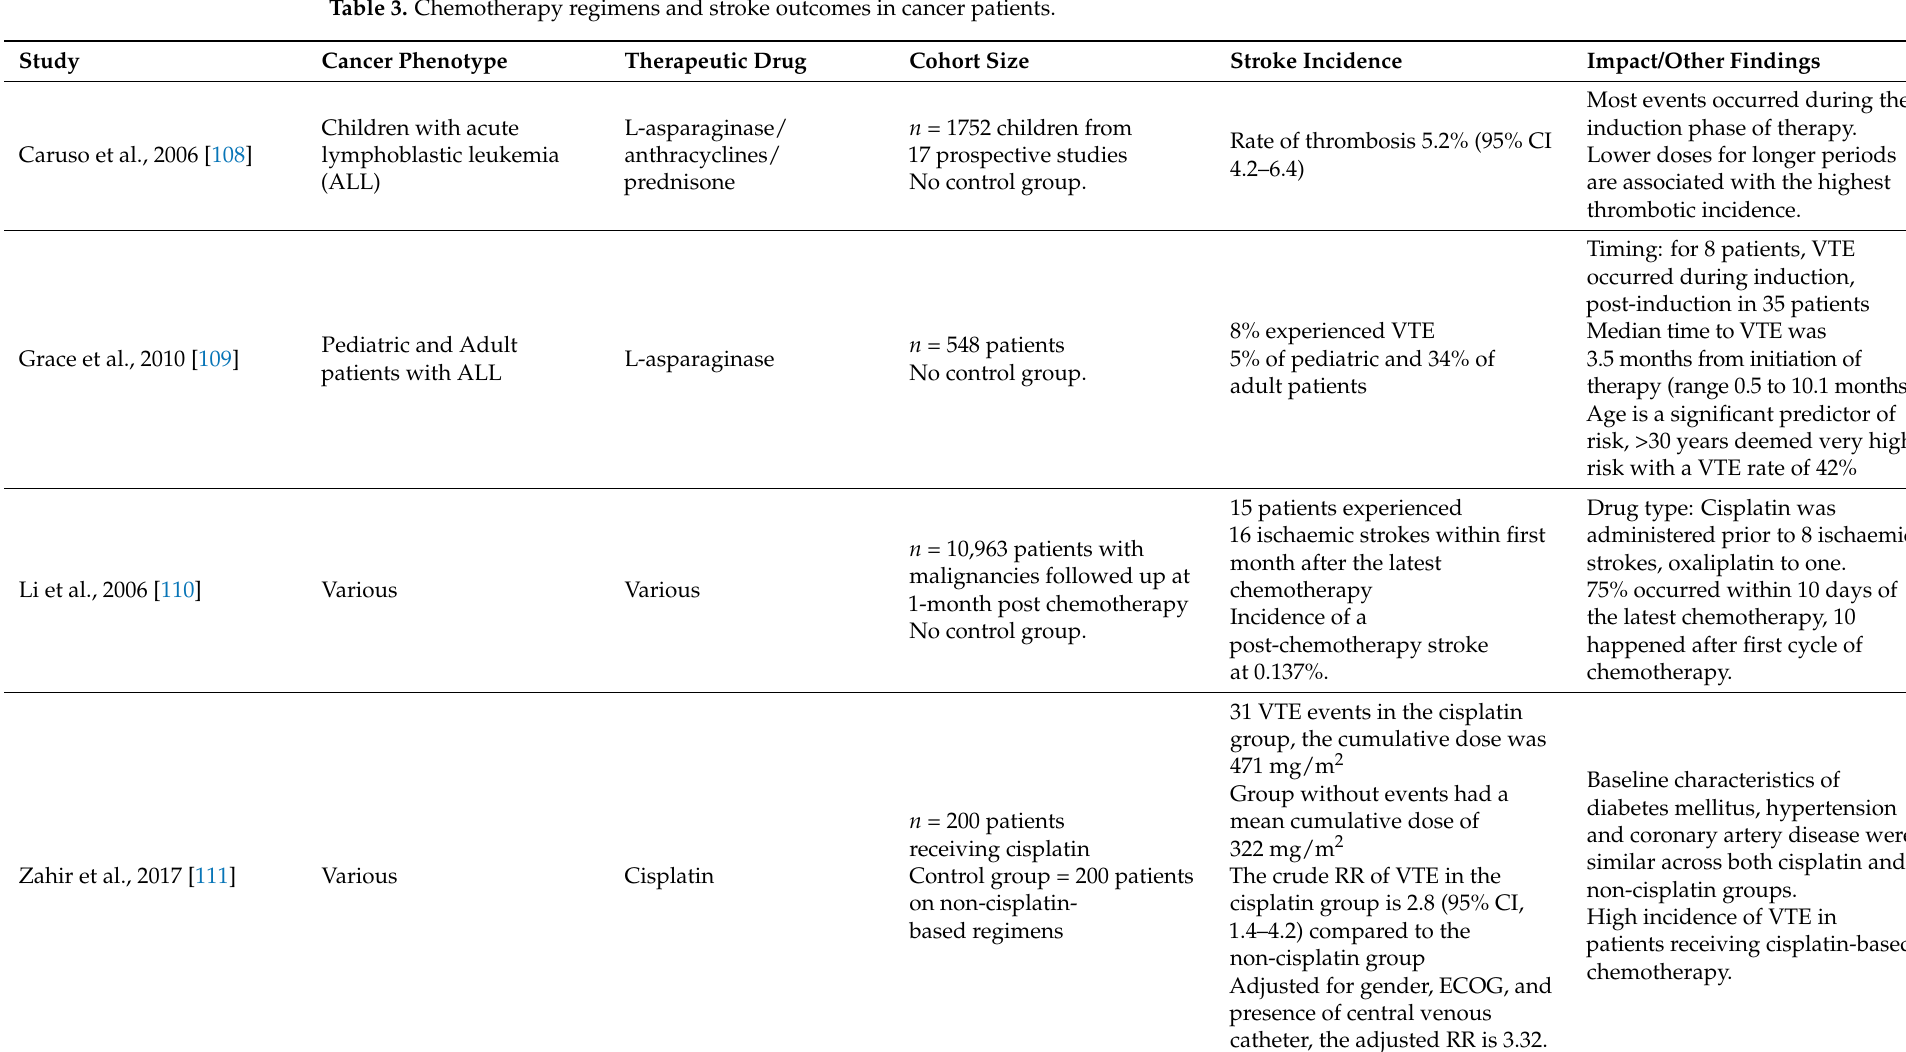
Table 3. Chemotherapy regimens and stroke outcomes in cancer